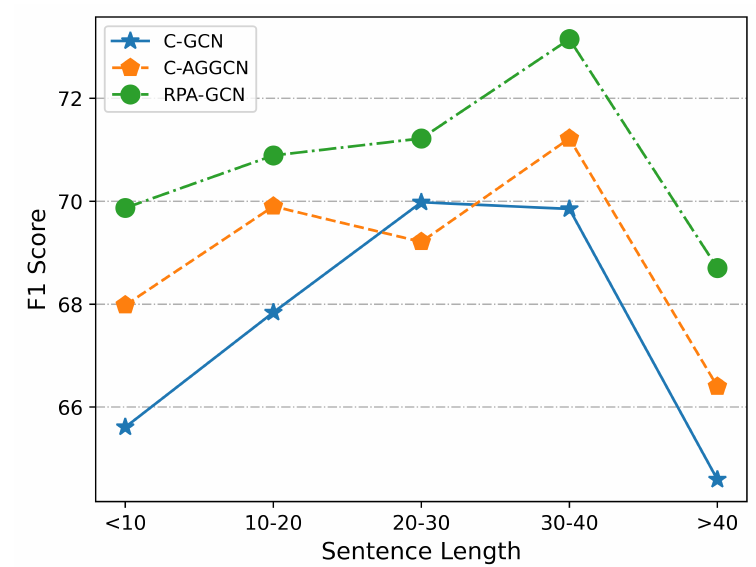
Figure 18. The effects of different sentence lengths on F1.